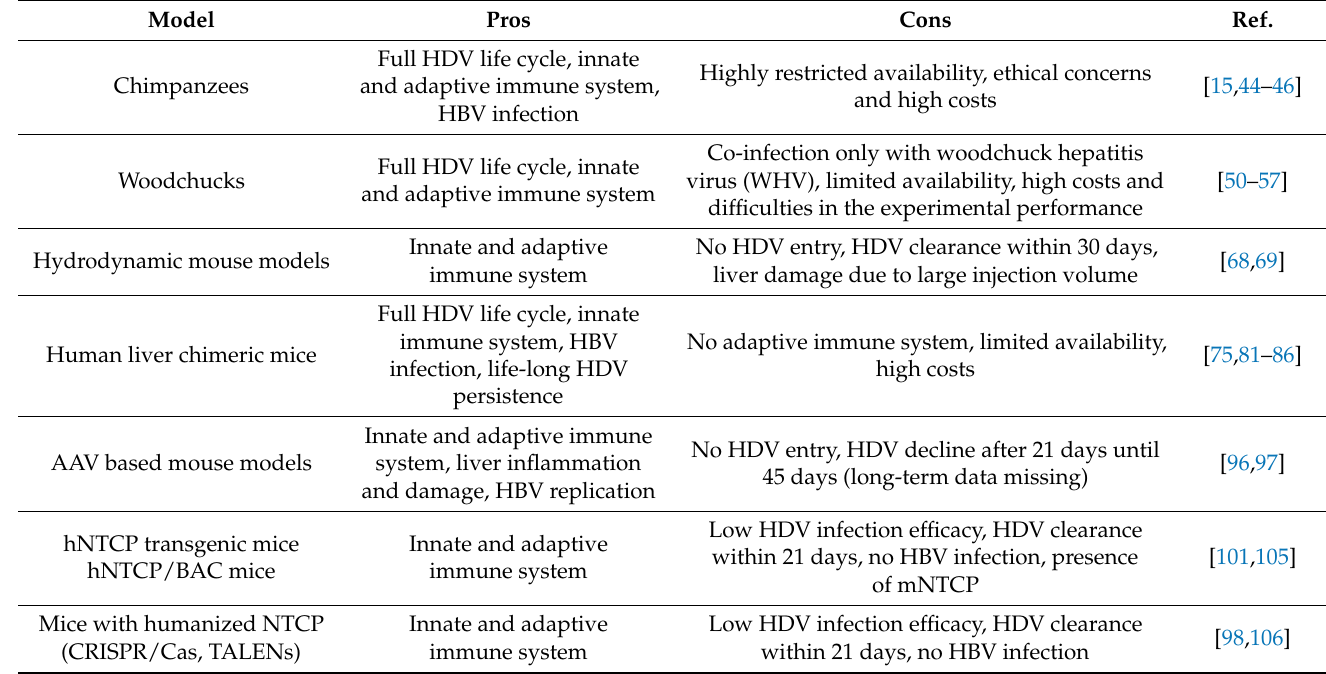
Table 1. Pros and cons of the different HDV in vivo